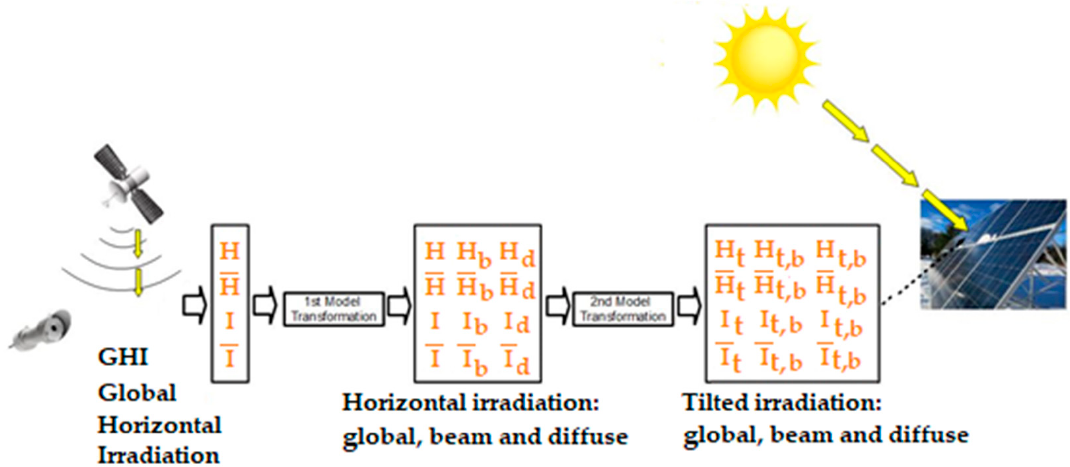
Figure 2. Characterization of solar irradiation in the scientific literature, dealing with either daily (H), average daily ( H(cid:3365) ), hourly (I) or average hourly ( I̅ ) global, beam ( b ) and diffuse ( d ) values. Source: own elaboration.